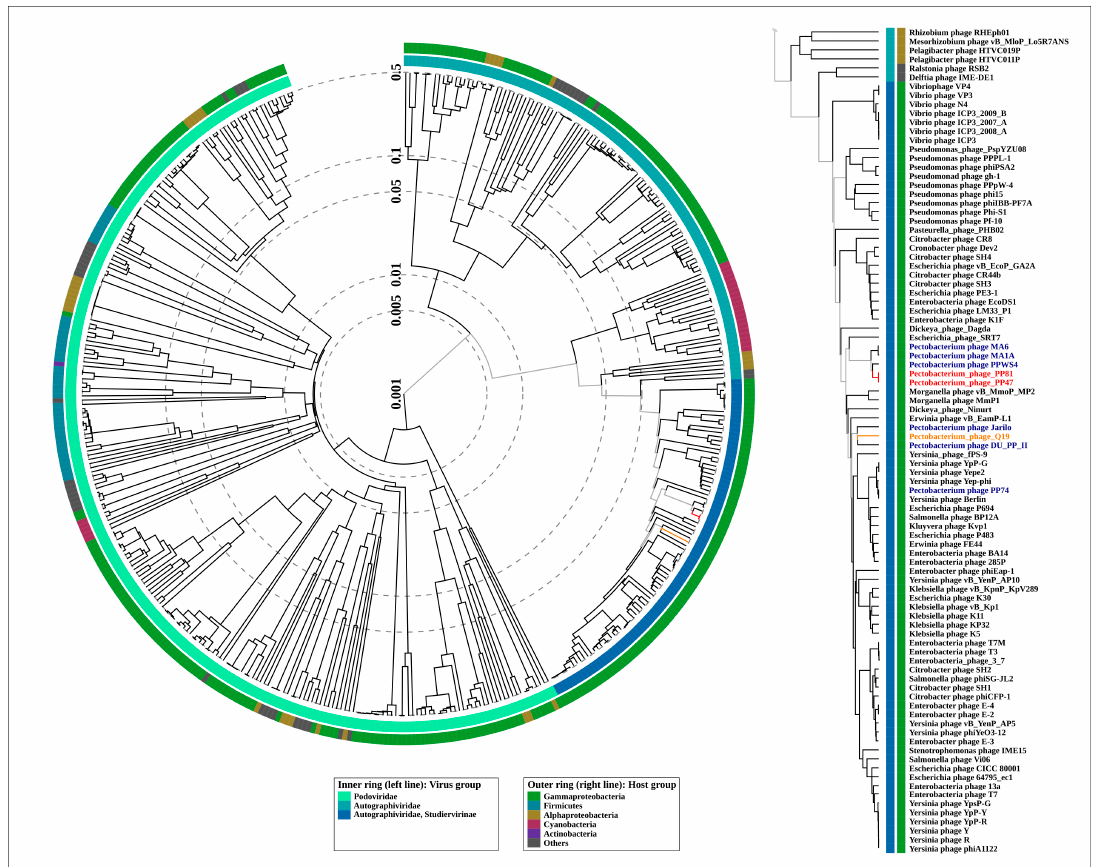
Figure 4. Circular proteomic tree of 447 Podovoridae and Autographiviridae phage genomes, and the Studiervirinae part of the tree (right) constructed using ViPTree. The branches representing Pectobacterium phages PP47 and PP81 are coloured red, and the branch representing Pectobacterium phage Q19 is coloured orange.